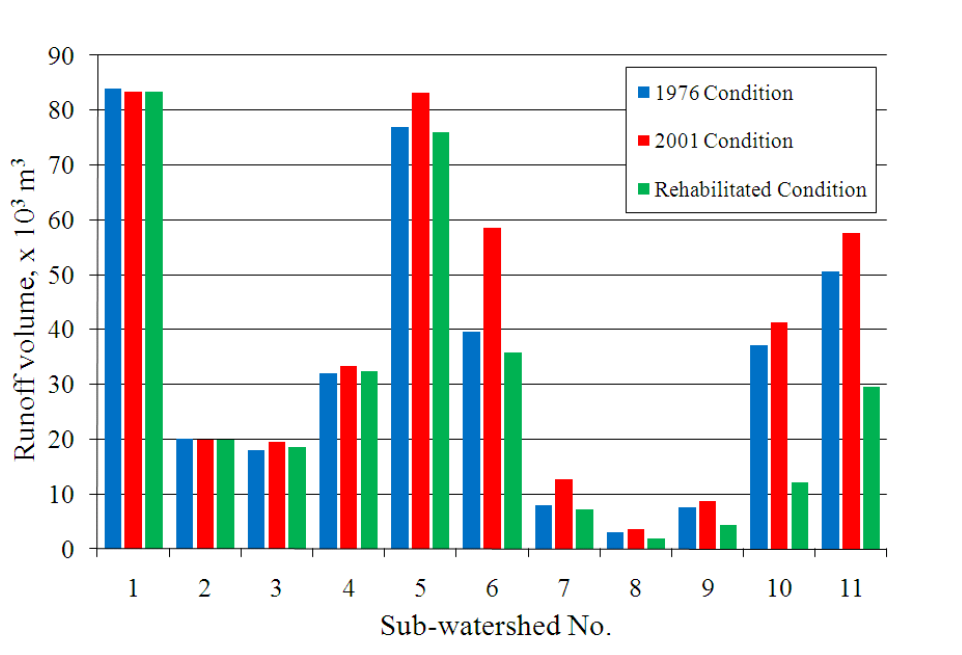
Figure 5. Model predicted accumulated runoff volume for the 11 sub-watersheds from 25 to 27 June 2007 under 3 land-cover conditions (25–27 June 2007 period).